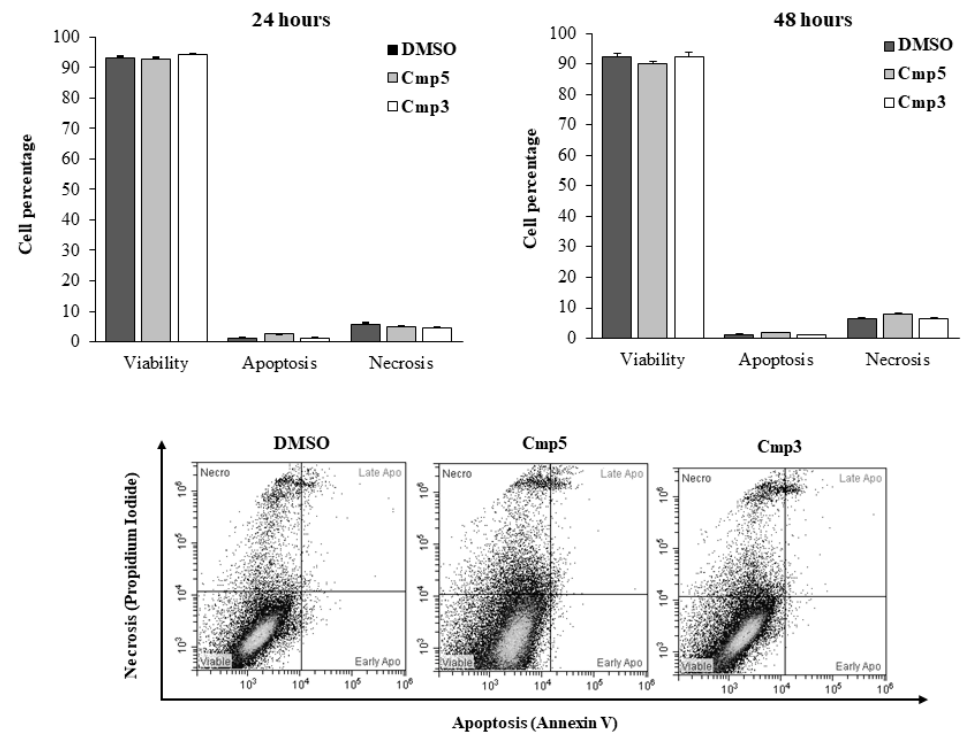
Figure 4. Induction of apoptosis and necrosis in C6 cells in the presence of Cmp 5 and Cmp 3 . Percentages of cells found in the various phases of cell death, analyzed by flow cytometry after staining with Annexin V-FITC and propidium iodide (PI), are shown in the upper panel. Bars represent the percentage of viable cells (unstained), cells in apoptosis (Annexin V-positive), cells in late apoptosis (Annexin V + PI), and cells in necrosis (PI) as medians ± SD calculated from three independent experiments. Representative dual-parameter fluorescence density dot plots at 48 h are displayed in the lower panel.